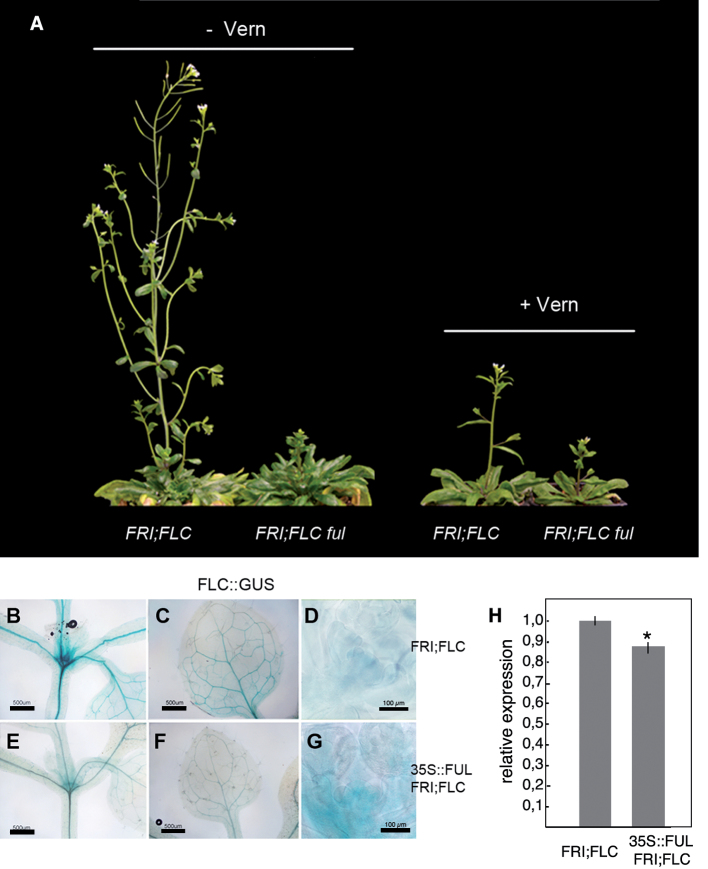

FUL over-expression suppresses the effects of high levels of FLC. (A) Vernalization response of FRI;FLC and FRI;FLC ful-2 in LD. The ful-2 mutation greatly enhances the late flowering phenotype of FRI;FLC unvernalized plants (left), while a vernalization treatment causes both genotypes to flower similarly earlier (right). (B–G) Histochemical detection of FLC::GUS activity in FRI;FLC (B–D) and FRI;FLC 35S::FUL (E–G) plants. Apices of 10-d-old plants are compared in (B) and (E), the first rosette leaf in (C) and (F), and inflorescence apices of plants at bolting in (D) and (G). All plants were heterozygous for the FLC::GUS reporter and for the wild-type dominant alleles of FRI or FLC. 35S::FUL in (E–G) was also heterozygous. Scale bars: 500 µm (B, C, E, F) or 100 µm (D, G). (H) Relative expression of FLC analysed by qRT-PCR in FRI;FLC and FRI;FLC 35S::FUL plants 10 d after germination. The error bars depict the s.e. based on two biological replicates. An asterisk (*) indicates a signiﬁcant difference (P <0.05) from the WT control according to Student’s t-test.